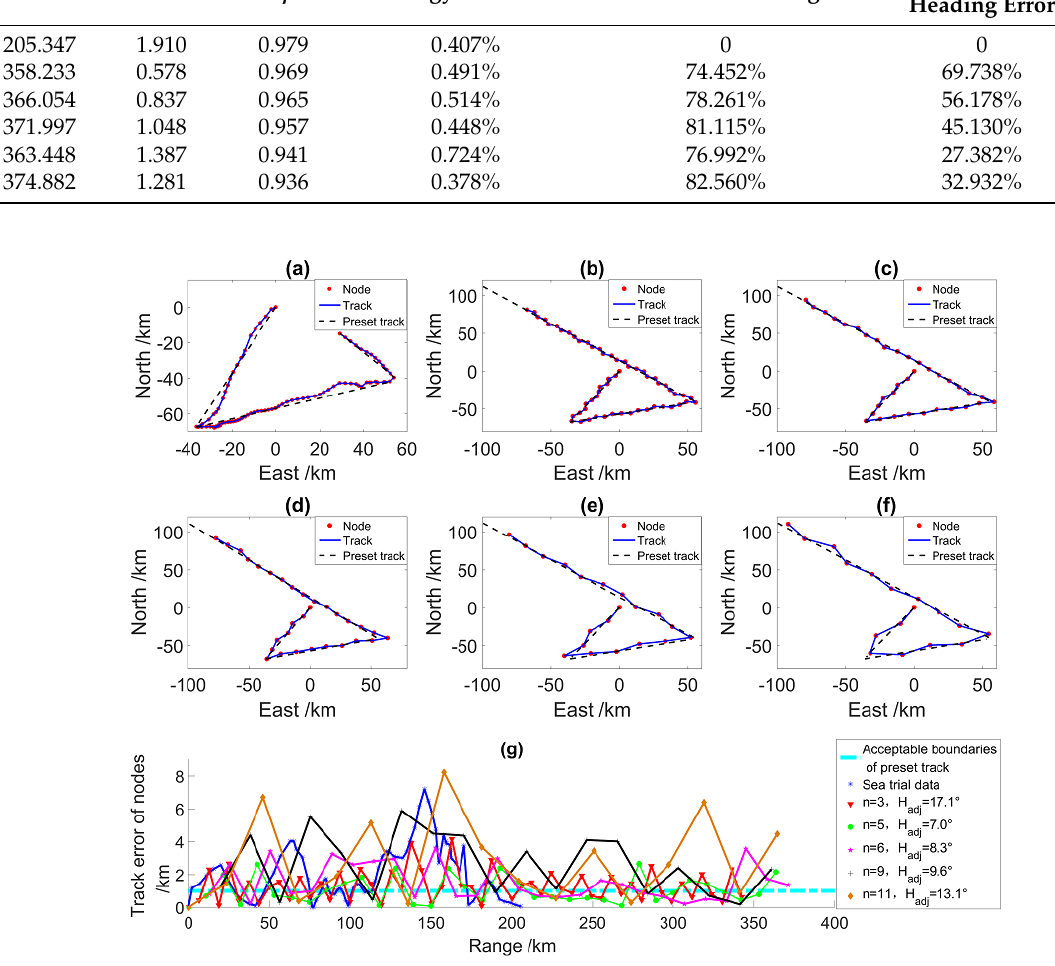
Figure 10. Comparison of navigation trajectories and related performances under different param- eters: ( a ) sea trial trajectory; ( b – f ) simulations of sailing trajectories under different parameters in Table 3; ( g ) the numeric comparison of trajectories for different